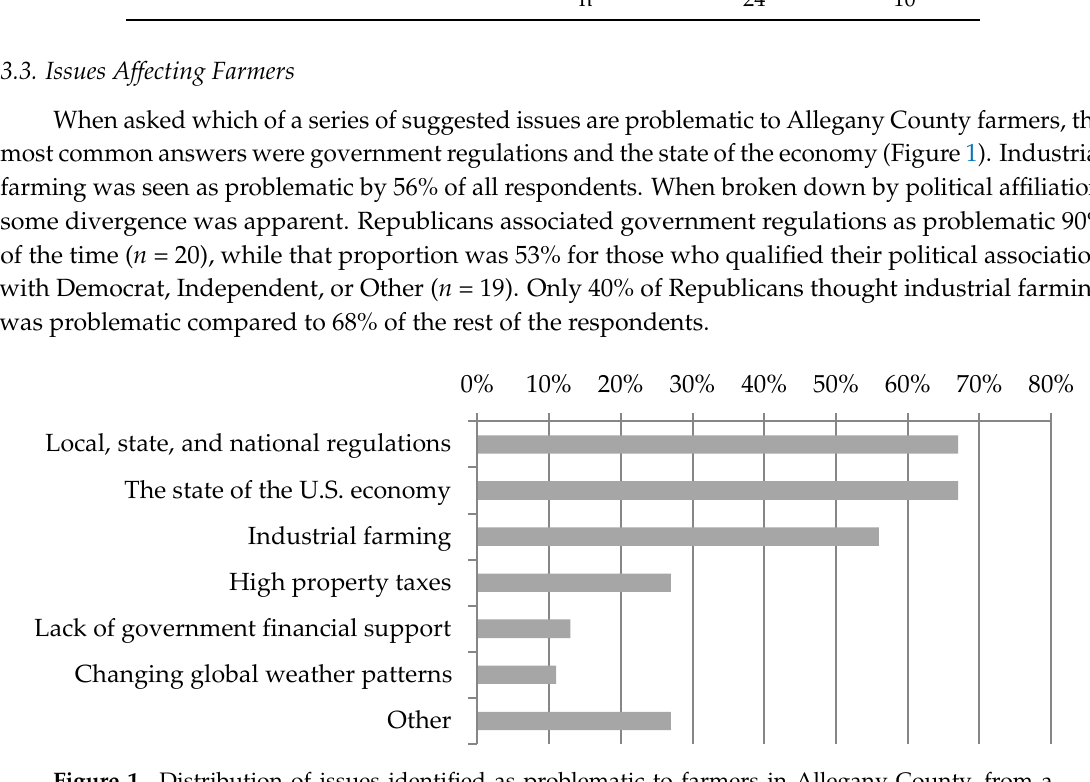
Figure 1. Distribution of issues identified as problematic to farmers in Allegany County, from a multiple-choice question. Respondents were farmers in Allegany County, New York ( n = 45).